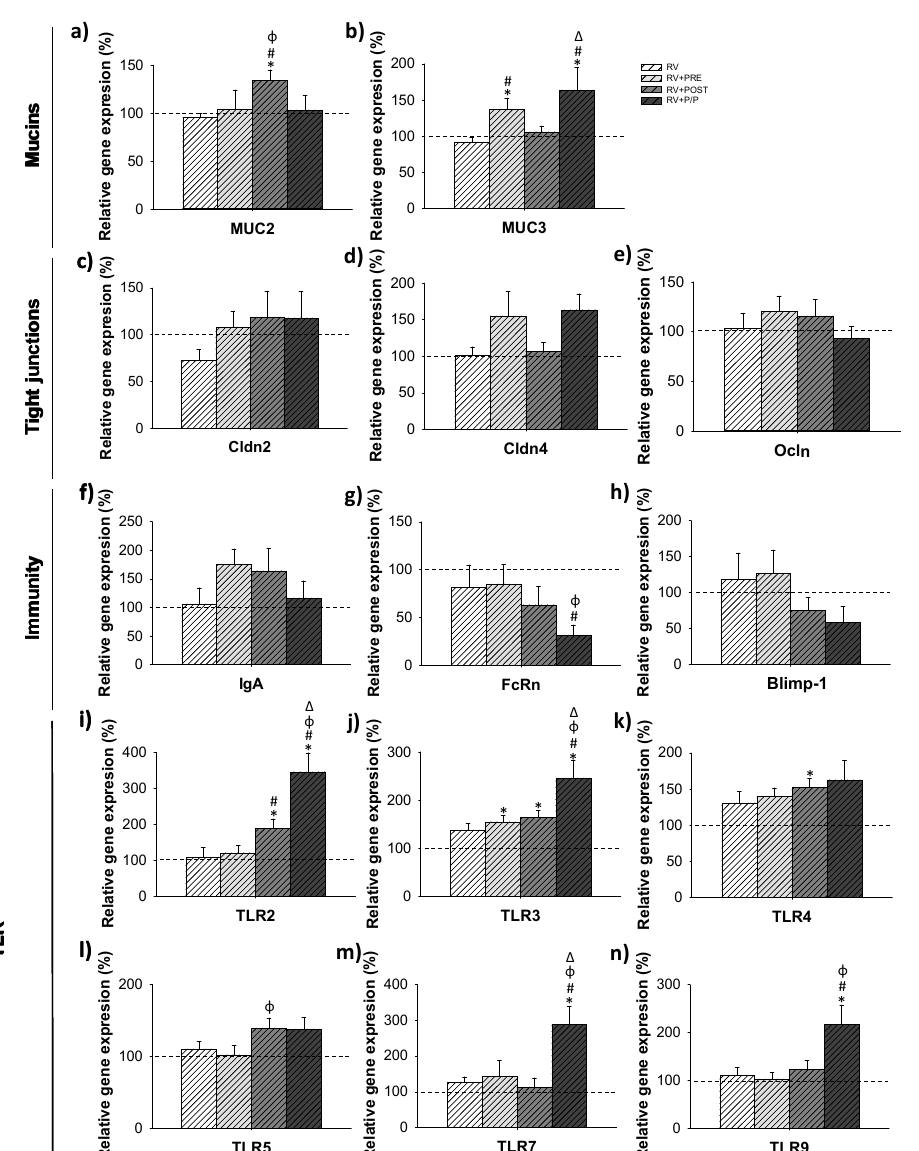
Figure 7. Relative gene expression of mucin (MUC) 2 ( a ) and MUC 3 ( b ), TJ proteins claudin (Cldn) 2, Cldn4 ( c ), and ( d ), respectively, and occludin, (Ocln) ( e ), immunity related molecules IgA ( f ), FcRn ( g ) and Blimp-1 ( h ) and Toll-like receptors (TLR) 2 ( i ), TLR3 ( j ), TLR4 ( k ), TLR5 ( l ), TLR7 ( m ), and TLR9 ( n ) was quantified by real-time PCR on day 16. Relative gene expression was calculated with respect to REF animals, which corresponded to 100% of transcription. Results are expressed as mean ± S.E.M. ( n = 9 animals/group). Statistical differences: * vs. REF, # vs. RV, ϕ vs. RV + PRE, Δ vs. RV + POST. REF: reference group; RV: rotavirus group; RV + PRE: rotavirus group supplemented with a mixture of scGOS/lcFOS; RV + POST: rotavirus group supplemented with Lactofidus TM ; RV + P/P: rotavirus group supplemented with the combination of both.